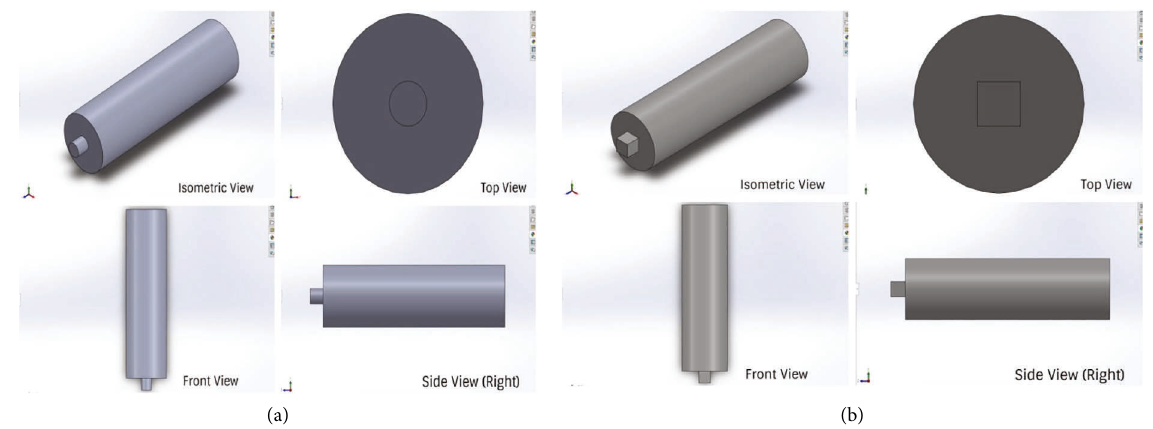
Figure 3: 3D modelling of tool design (a) round tool and (b) square tool.